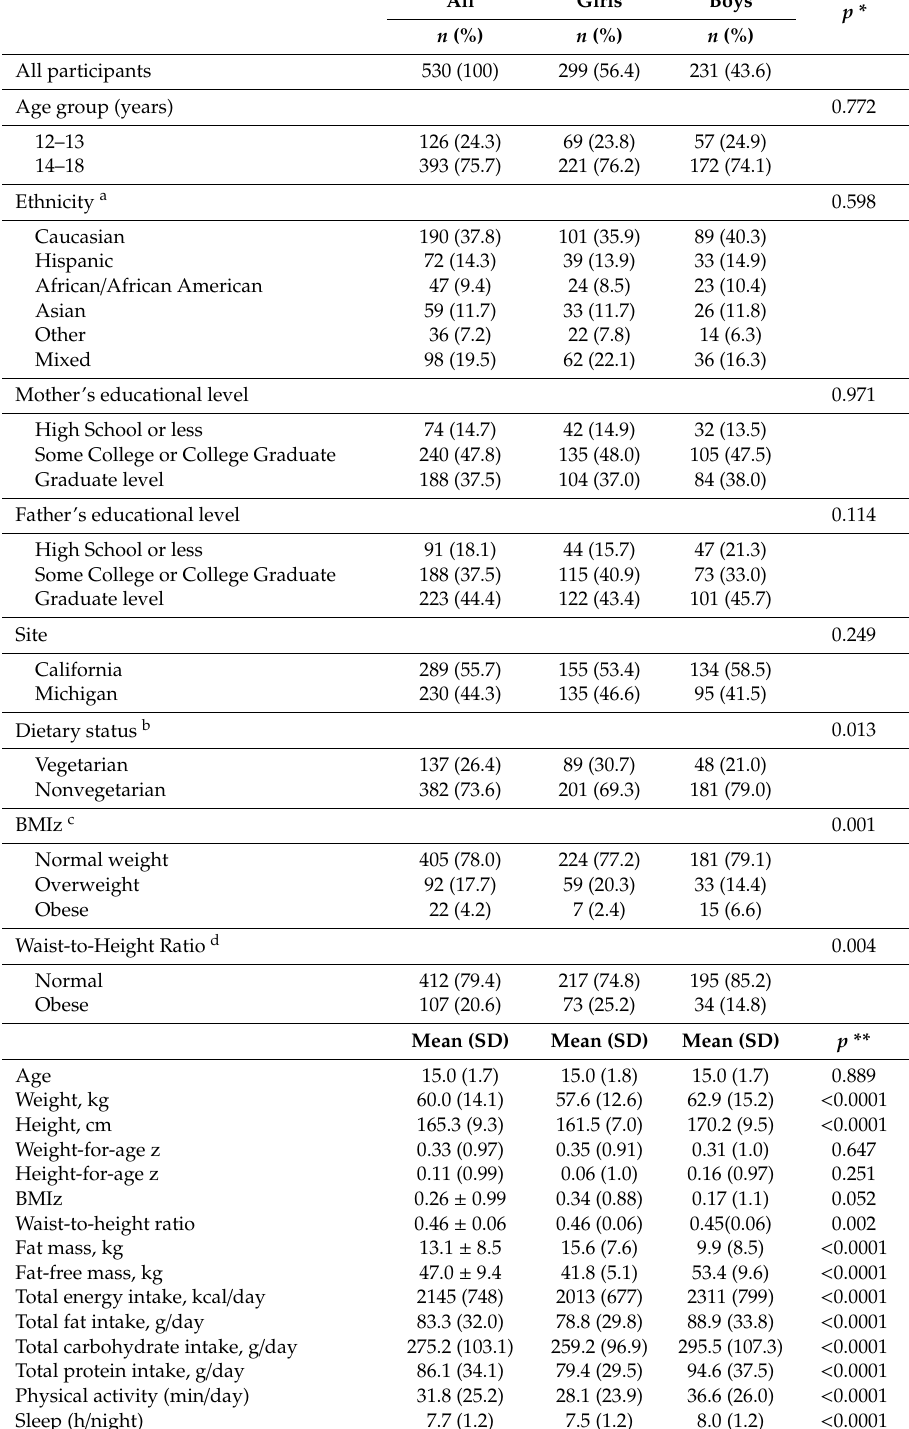
Table 1. Demographic characteristics and anthropometric / body composition measurements, macronutrient intake and lifestyle habits of participants, collectively and by gender groups.